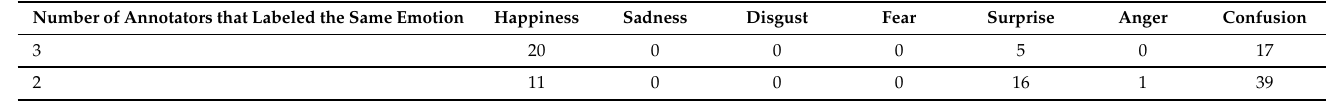
Table 4. Summary of annotators’